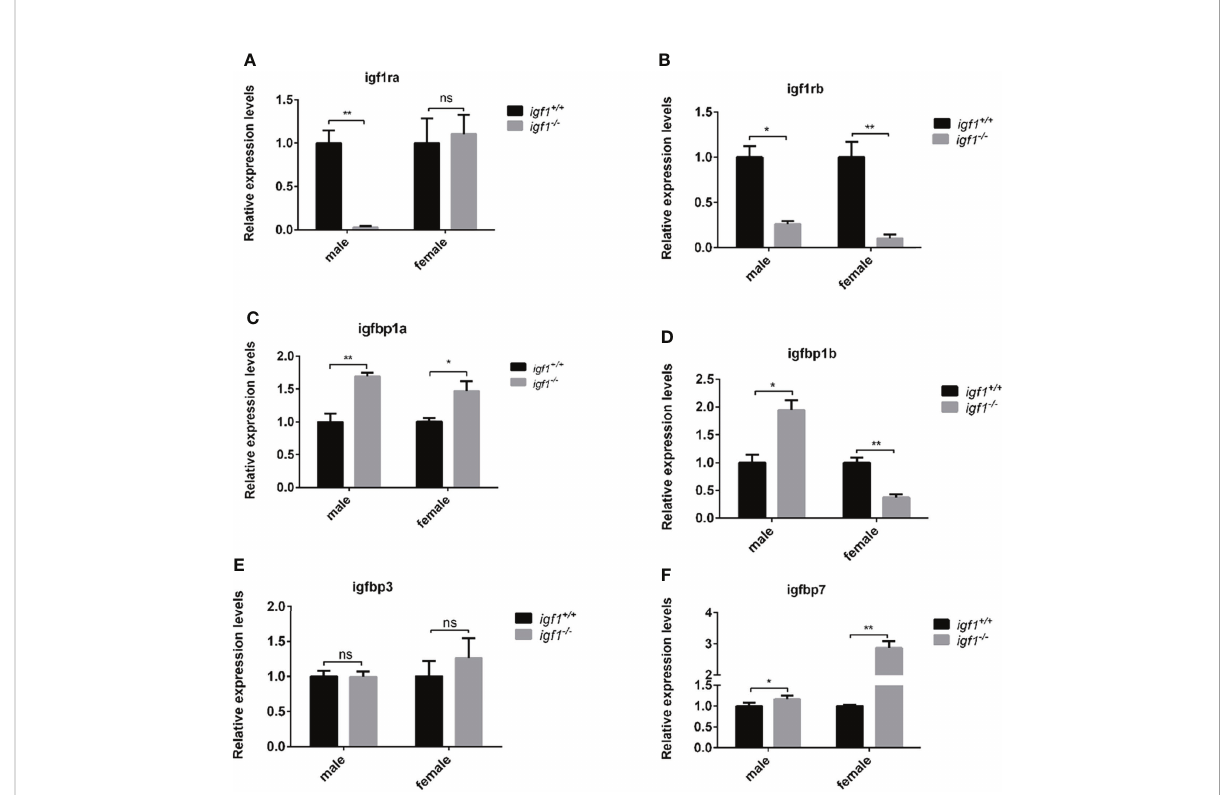
FIGURE 3 Transcriptional levels of igf1 related genes (A, B) Relative expression levels of igf1ra and igf1rb in igf1 -de fi cient fi sh and the control wild-type fi sh and three biological repeats were carried out and statistical analysis was performed using a t test (n=3). (C – F) Relative expression levels of igfbp1a , igfbp1b , igfbp3 and igfbp7 in igf1 -de fi cient fi sh and the control wild-type fi sh and three biological repeats were carried out and statistical analysis was performed using a t test (n=3). There was no difference between the two internal reference gene ( b -actin and EF1 a ). Four animals were sampled for each experiment and three biological repeats were carried out and statistical analysis was performed using a t test (p<0.001, n=3). **P <